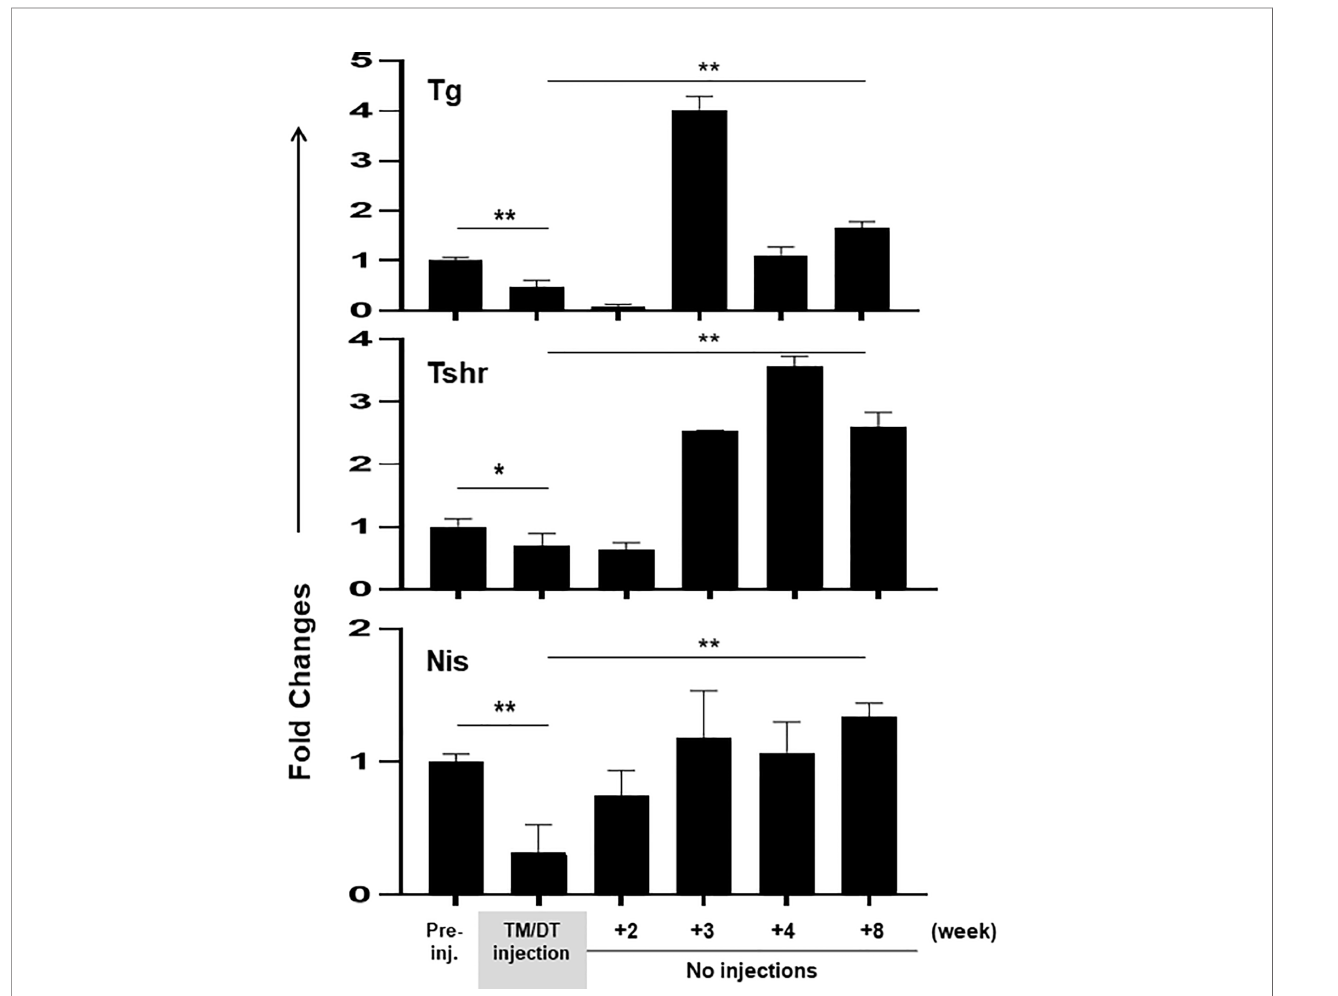
FIGURE 4 | Thyroid gene expression in thyroid glands from TPOCreER2/iDTR mice: Total mRNA were isolated from the thyroid glands of each group of mice (n = 4 – 5) at time points as indicated on the X-axis. Five micrograms total RNA were used for the RT-PCRs. The relative expression of each transcript is presented as fold change compared to control non-injected samples (mean±SEM of three independent experiments). The thyroid speci fi c genes (TG, TSHR, and NIS) decreased after 4 weeks TM/TD treatment with an average ~50% fall in activity in comparison to controls (p < 0.05, or p < 0.01). After stopping treatment the gland showed a robust return to full thyroid gene activation, beginning after 2 – 3 weeks (p <